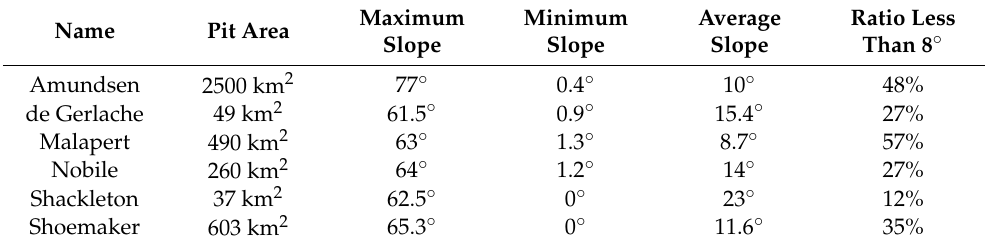
Shoemaker 603 km 2 65.3 ◦ 0 ◦ 11.6 ◦ 35%